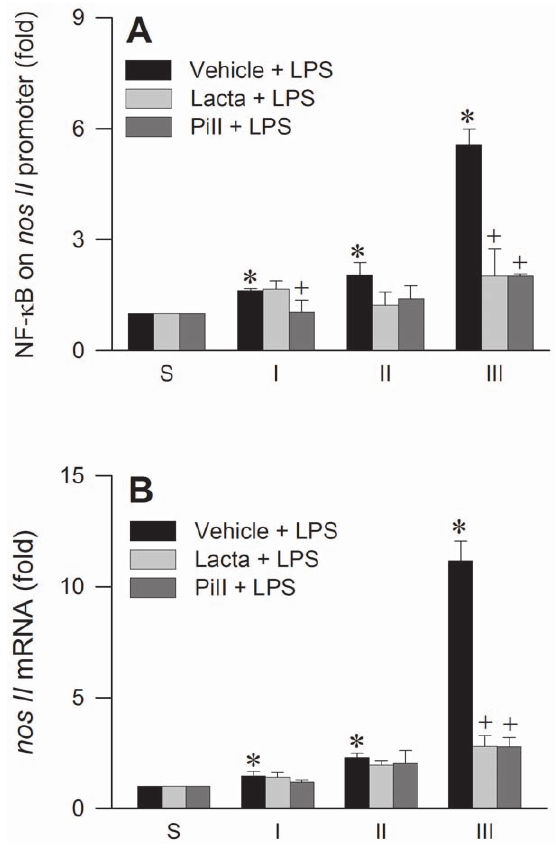
Figure 4. NF- k B transcriptionally activated by UPS binds to nos II promoter in RVLM. Phasic fold changes against sham-controls in (A) binding between NF- k B and nos II promoter measured by ChIP assay, or (B) nos II mRNA level determined by real-time PCR analysis in ventrolateral medulla of rats that received pretreatment by microinjec- tion bilaterally into RVLM of lactacystin (Lacta; 1 nmol), proteasome inhibitor II (PiII; 1 nmol) or their solvent (vehicle), followed by IV administration of LPS (15 mg kg 2 1 ). Values are mean 6 SEM of triplicate analyses on individual samples obtained from 5–6 animals per experimental group. *P , 0.05 versus sham-control group, and + P , 0.05 versus Vehicle + LPS group at corresponding phases in the Scheffe´ multiple-range